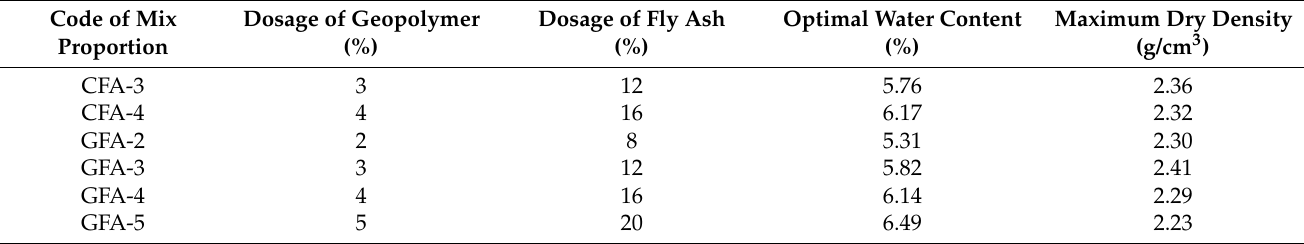
Table 4. Results of heavy compaction test of geopolymer-stabilized